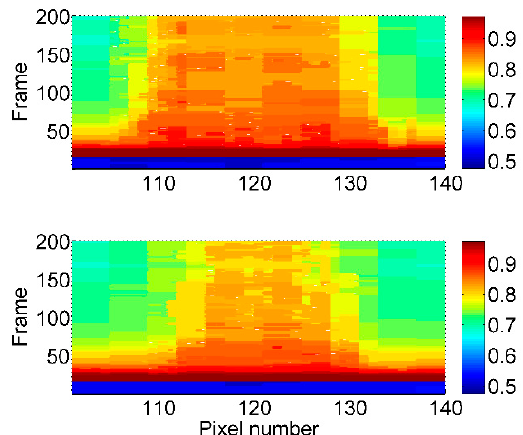
Figure 10. Pixel intensity variation along lines 82 (top) and 87 Figure 11 . Pixel intensity variation along lines 82 (top) and 87 (bottom).